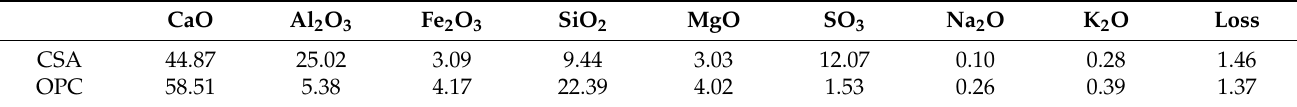
Table 1. Chemical compositions of CSA and OPC cement (wt.%).